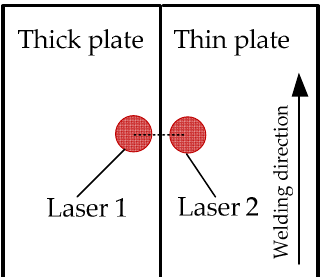
Figure 8. The arrangement mode I of dual-beam laser: one laser beam irradiates on the thick plate and the other laser beam on the thin plate. The line connecting the dual-beam laser focused spot centers is perpendicular to the welding direction.